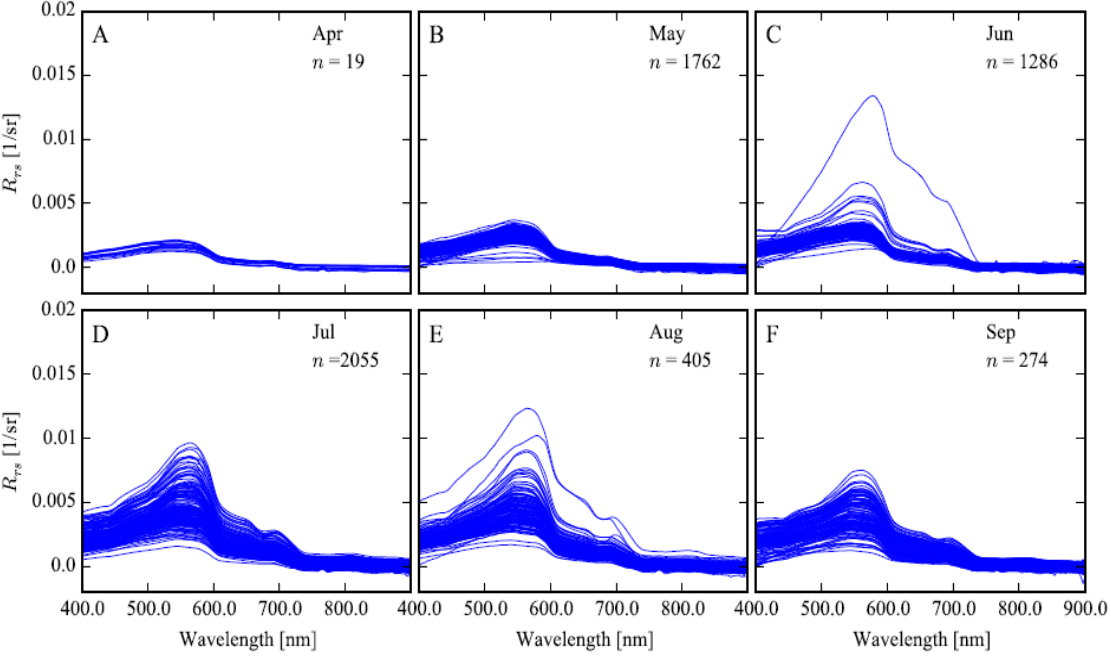
Figure 2. In situ remote sensing reflectance spectra ( R rs ( λ ) ) collected on Alg@line campaigns in the Baltic Sea in 2016 during ( A ) April, ( B ) May, ( C ) June, ( D ) July, ( E ) August and ( F ) September.